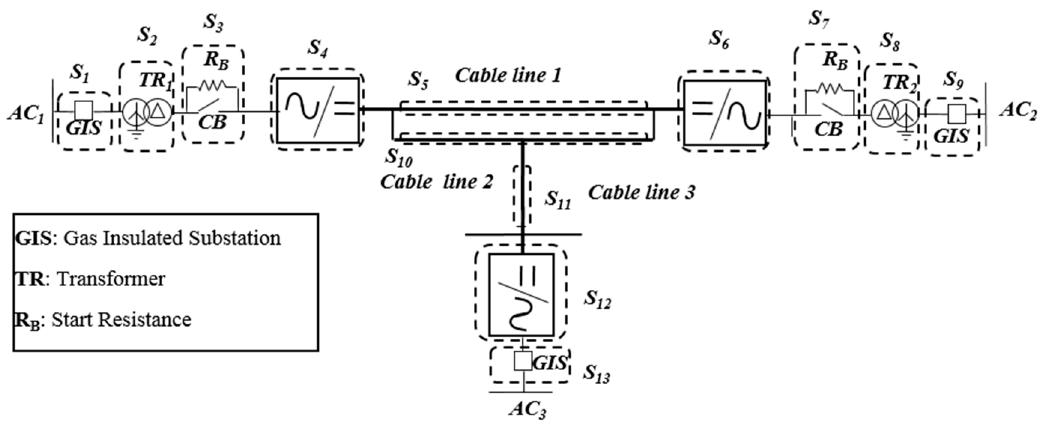
Figure 1. Electrical scheme of a HVDC multi-terminal connection divided in sub-systems.